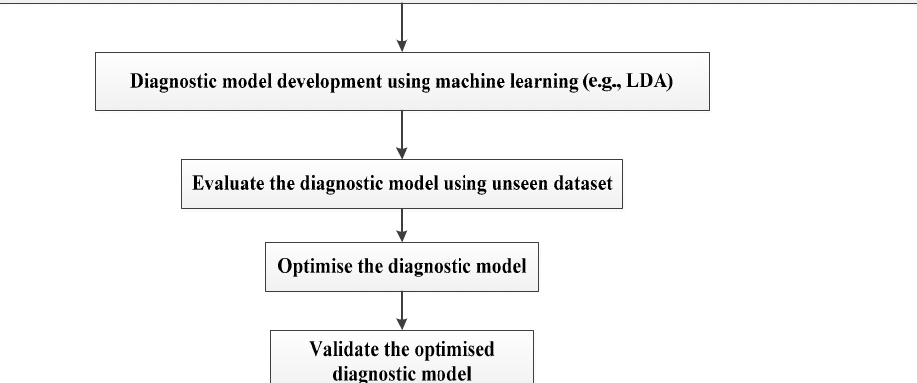
Figure 2. Methodological framework that was used for developing robust EEG ‐ based biomarkers.